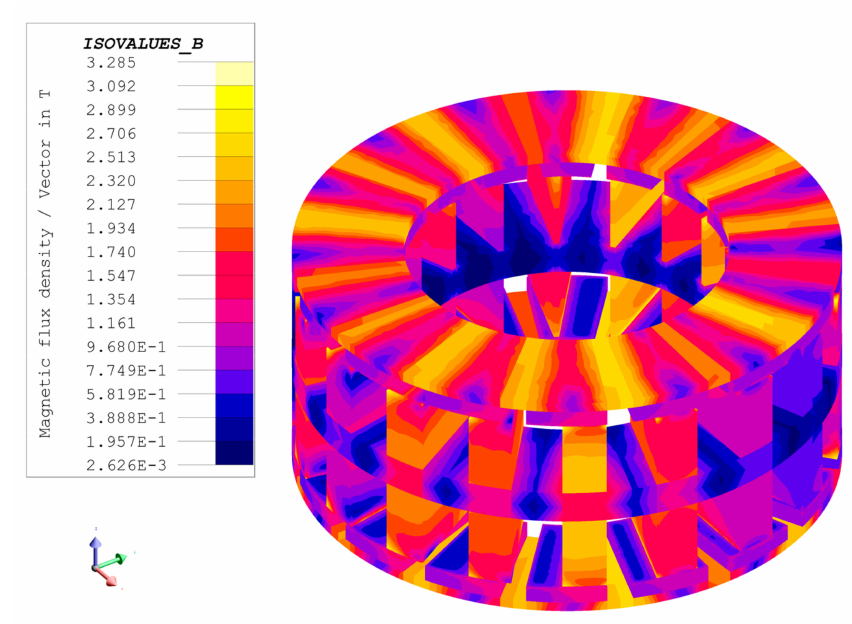
Figure 8. The flux density distribution at 28 A (in